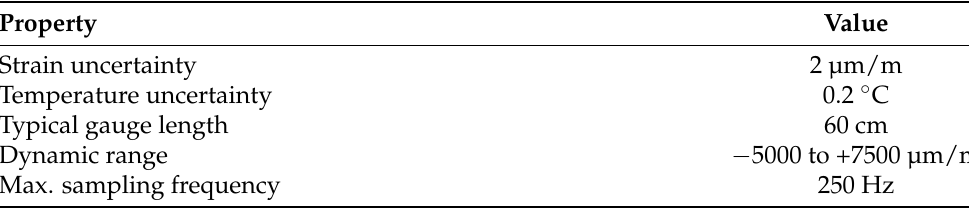
Figure 1. Segment P10-P11 of Streicker Bridge (all distances in meters). Inset shows a picture of the bridge span of interest with instrumented sections highlighted. Table 1. Fiber optic sensor